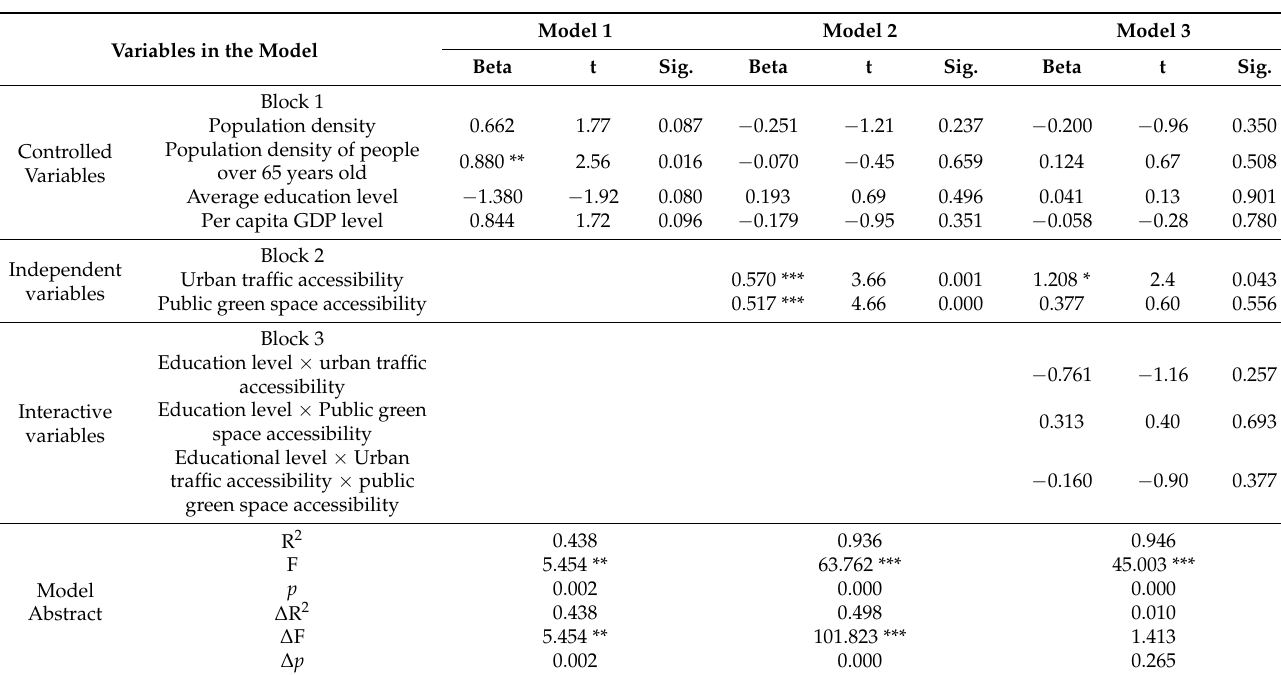
Table 2. Multivariate Hierarchical Regression Analysis of Public Facilities Accessibility for the Spatial Distribution of Taijiquan